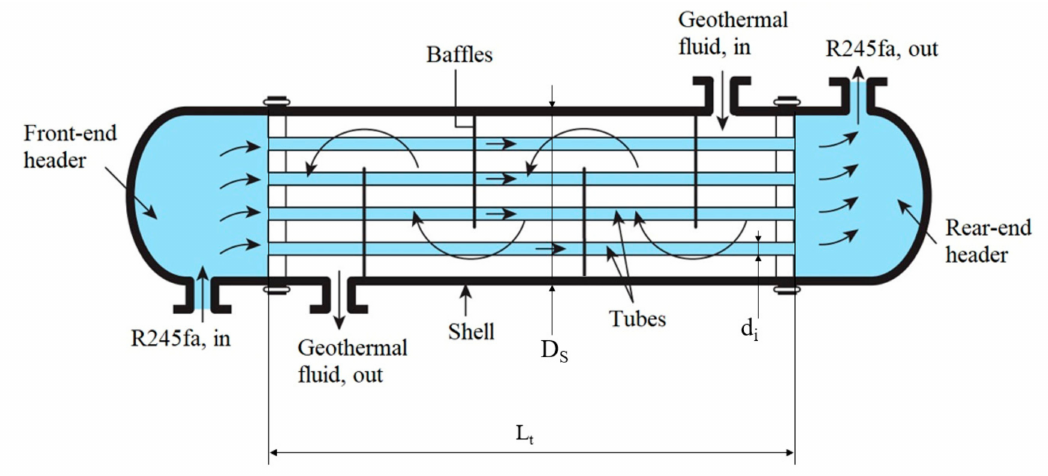
Figure 4. Shell and tube heat exchanger